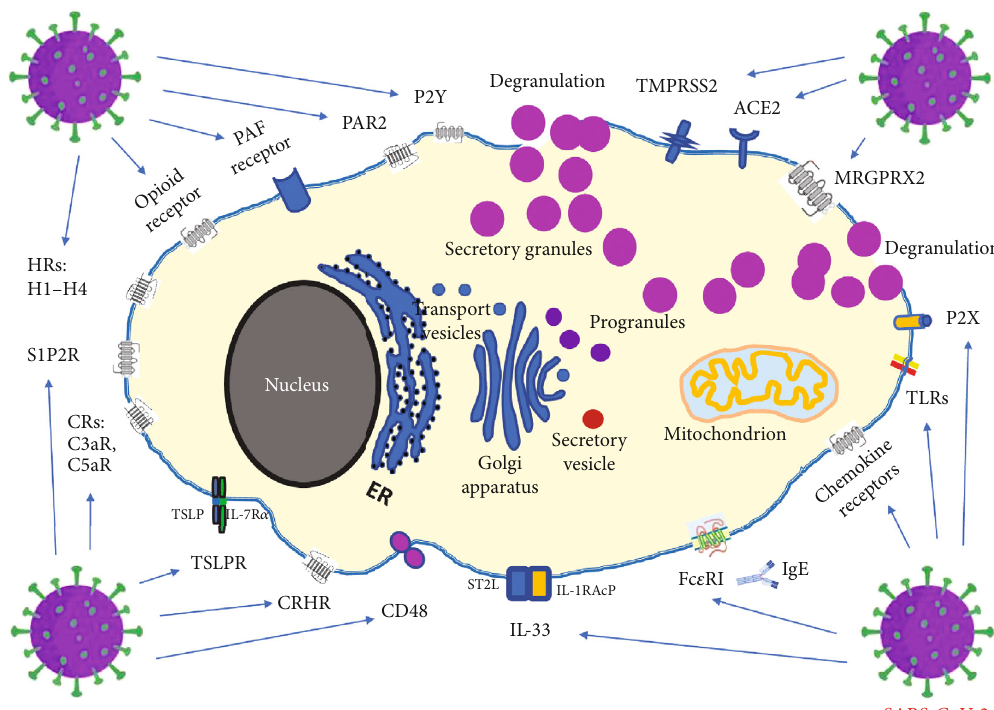
Figure 1: Receptors with a documented role in MC activation and degranulation in the context of possible triggering by coronavirus/